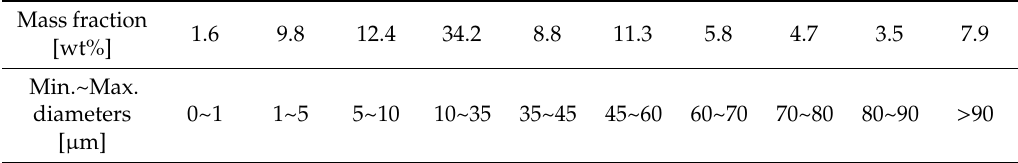
Table 2. Particle size distribution of test